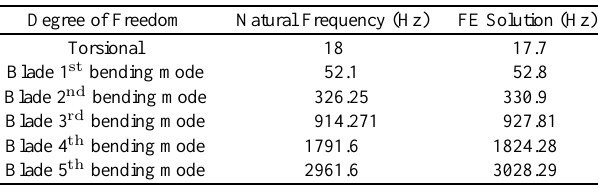
Table 2 Uncoupled system natural